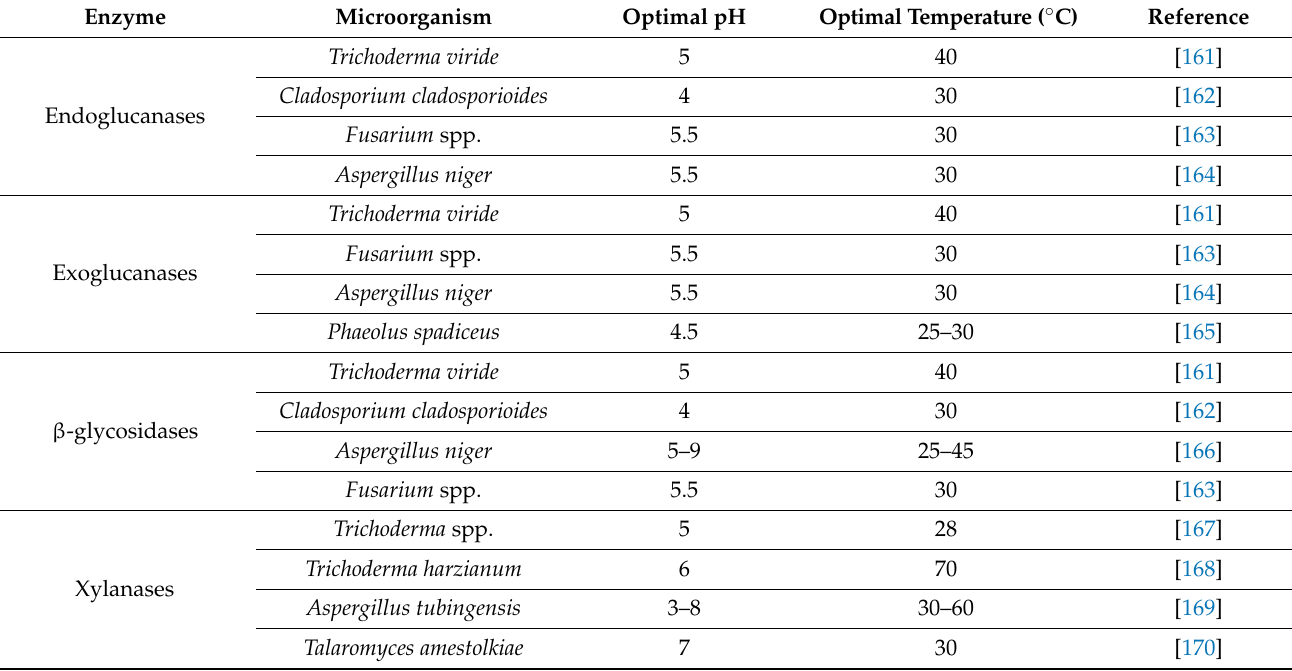
Table 2. Examples of fungi producing lignocellulolytic